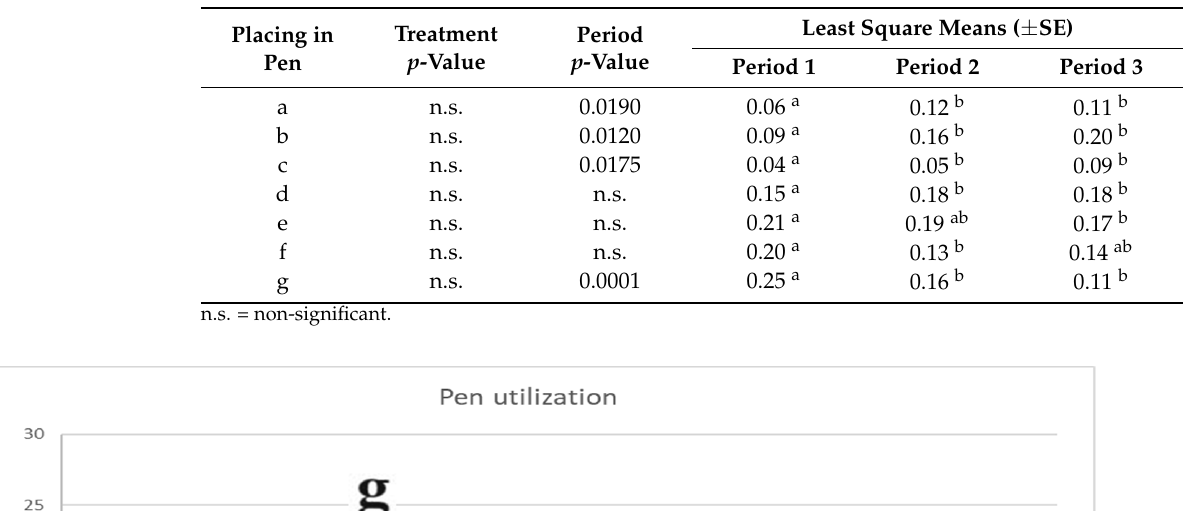
Table 4. Difference in pen utilization between treatments. The interaction between treatment and period was removed as proven non-significant based on AIC values. The covariance structure variance component was used for all modes and determined through AIC values. Least square means followed by different letters indicate significant difference between periods.